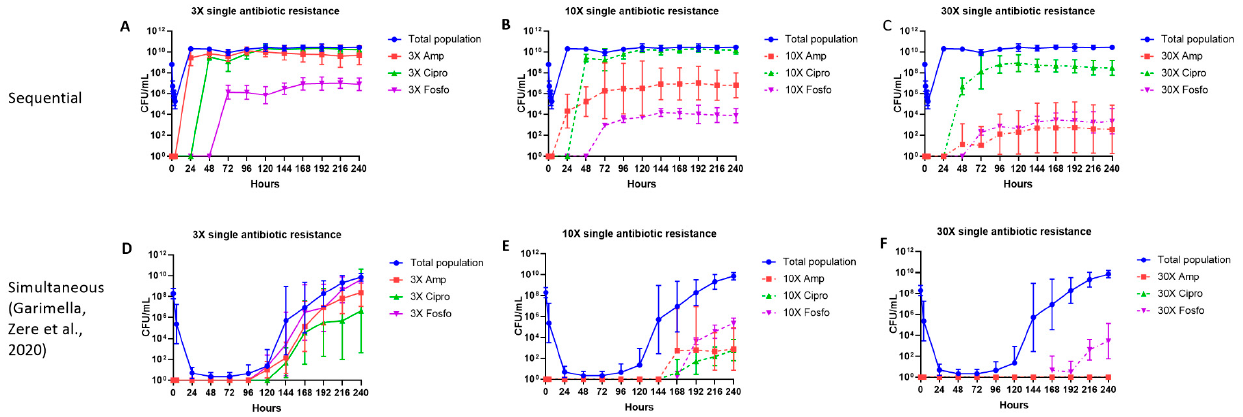
Figure 2. The effect of ampicillin, ciprofloxacin and fosfomycin sequential ( A – C ) and simultaneous combination ( D – F ) [23] therapy regimens on the total population and single antibiotic-resistant subpopulations in the hollow fiber infection model over 10 days. The 3×, 10× and 30× single antibiotic-resistant subpopulations were grown on agar containing the respective antibiotic minimum inhibitory concentration (MIC) levels. Data are presented as the geometric mean of three (Sequential regimen), and four (Simultaneous combination regimen) independent hollow fiber runs, and the error bars represent the geometric standard deviation.